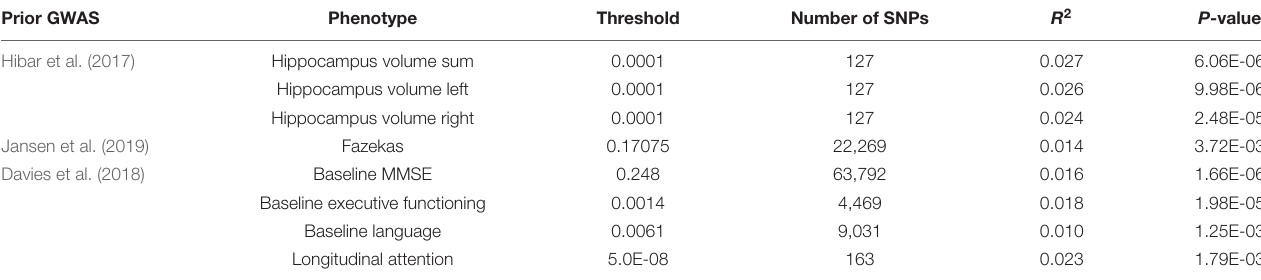
TABLE 3 | Summary of PGS results significant after multiple testing